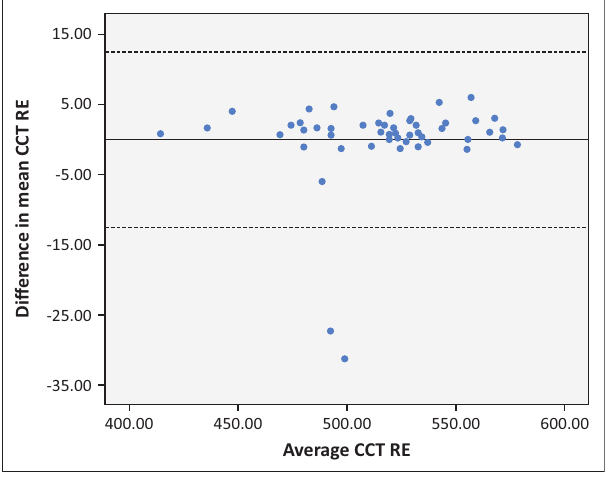
CCT RE, central corneal thickness Right Eye. FIGURE 2: Bland–Altman plot comparing iVue-100 spectral domain optical coherence tomographer central corneal thickness measurements of the right eyes taken by two observers. The solid line represents the mean difference (0.007 µ m ± 6.382 µ m) and the dashed lines represent the two limits of agreement (12.52 µ m; -12.50 µ m).